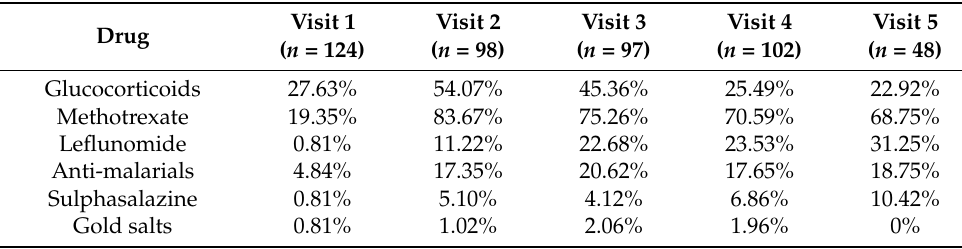
Table 2. DMARD treatment prescribed at each